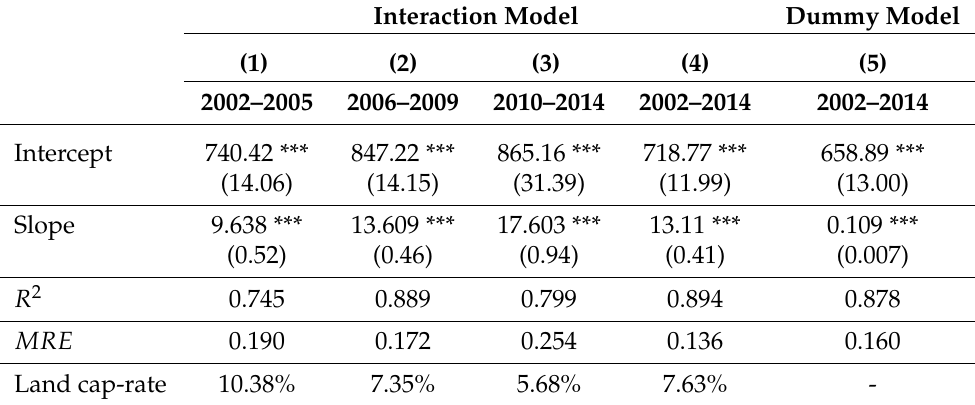
Table 2. Regression results for land price prediction. (This table shows the regression results of regional (aggregated) average land prices on implicit relative land rents of each planning region (Equation (15)). MRE stands for mean relative error. The land capitalization rate is the inverse of the slope. These figures are either based on the results of the interaction model (Equation (13)) or the dummy model (Equation (14)), which serves as a benchmark model. Moreover, figures are calculated for different sub-periods (estimations (1–3)) as well as for the whole time period from 2002 to 2014 (estimations (4) and (5)). The land capitalization rate decreases over the three sub-periods from 10.38% (2002–2005) to 5.68% (2010–2014). The number of observations is 121. Heteroscedasticity-robust standard errors are shown in